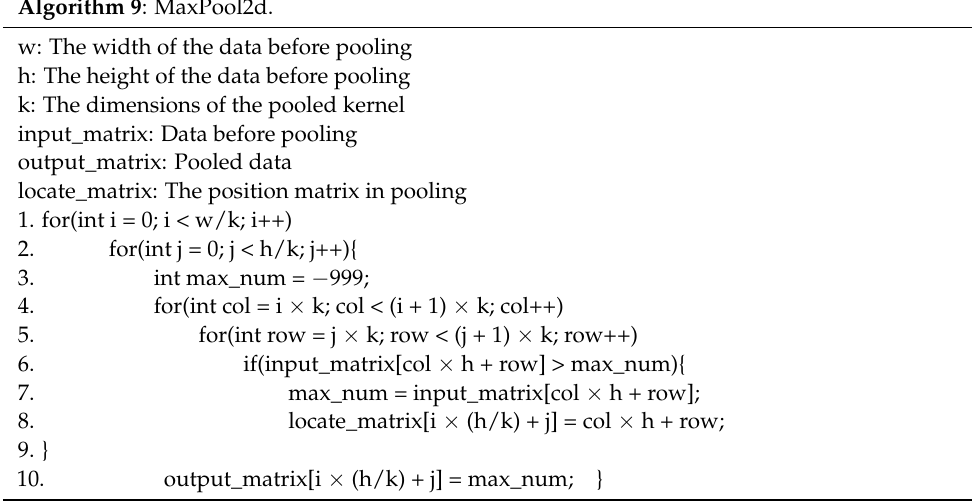
Table 1. LeNet-3.3 IP core resource usage details.